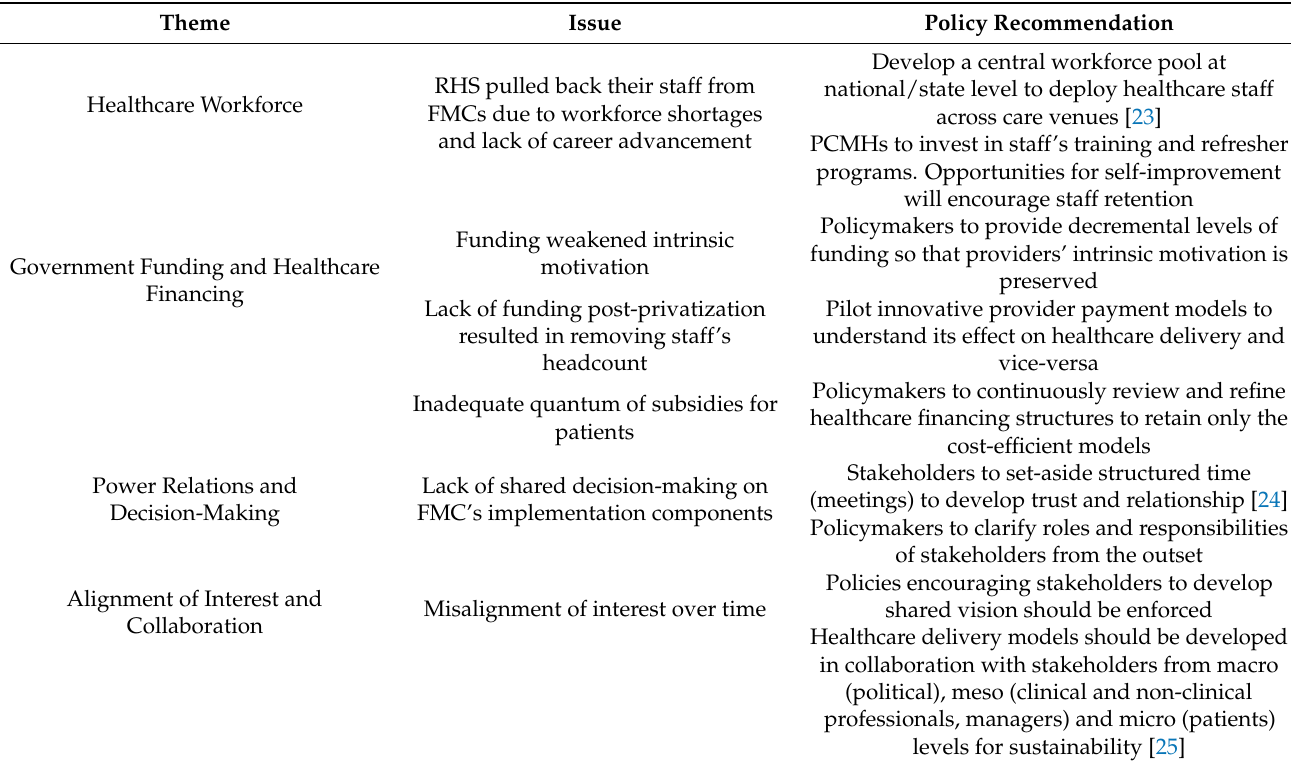
Table 3. Themes, issues, and policy